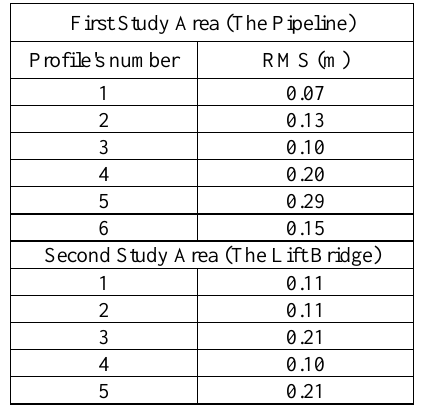
Table 1. The RMS Errors of the